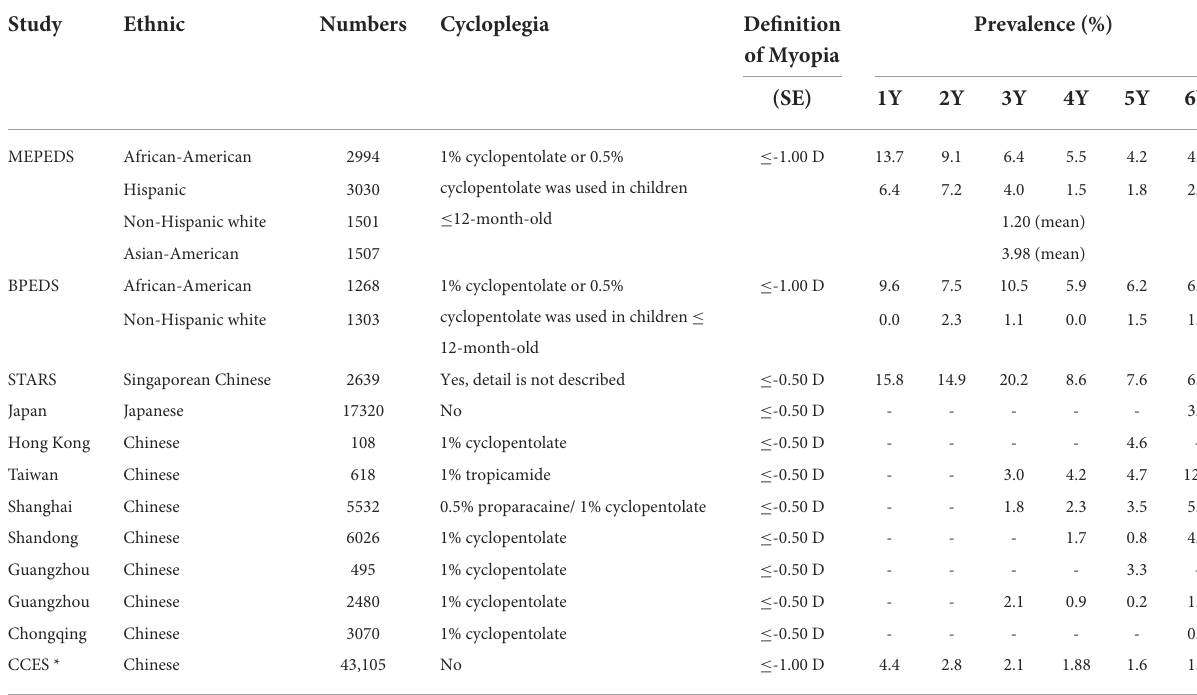
TABLE 6 Studies about prevalence of myopia among preschool children